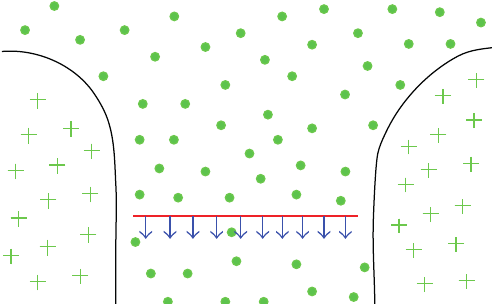
Figure 5: Magnetic force field of the false active contour.